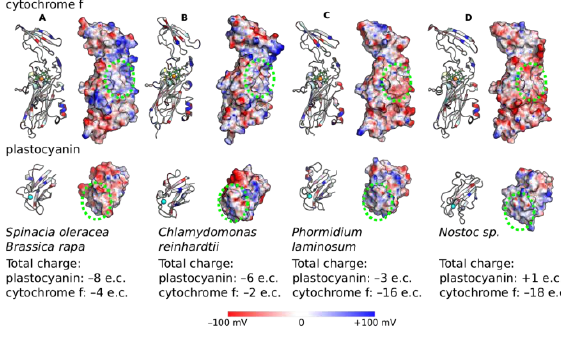
Fig. 5. Secondary structures and equipotential surfaces of proteins. Surfaces are colored according to the electric potential field from –100 mV (red) to +100 mV (blue). Contact areas are marked in green. The protein structures are oriented so that contact zones are visible. Secondary structures are colored by the type of amino acid residues of proteins. Hydrophobic residues are colored gray, aromatic pink, polar light blue, positive blue, negative red, cysteine yellow, proline green. The spheres are atoms of iron (orange) and copper (cyan)